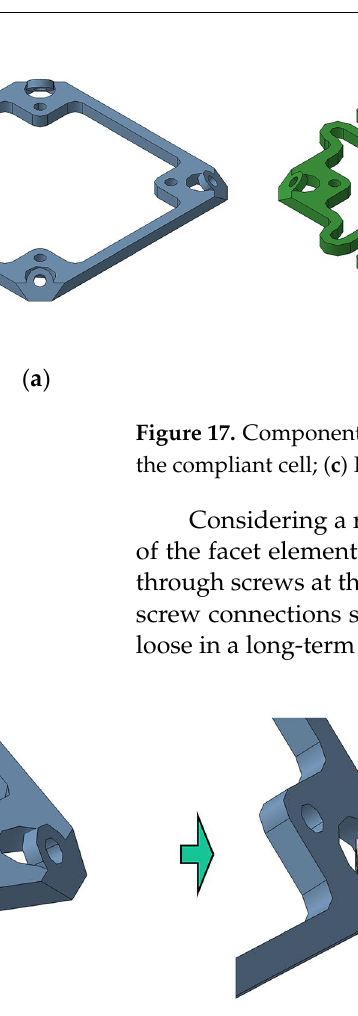
14 of 24 Figure 16. Schematic diagram of the active drive cell and axial unit. 2.4. Reversible Assembly Manner A basic principle to qualify a lattice structure as a digital metamaterial is based on whether the lattice is reversibly assembled. This characteristic ensures the structure to be replaceable in the event of local failure. Therefore, how to define a reversible assembly manner is very important. Similar to the method in the literature [35], this paper adopts a screw connection method for the reversible assembly within and between different cells. By examining the internal structure of the three basic cells, it can be found that every unit cell can be further divided into six identical facet elements. Therefore, these facet elements